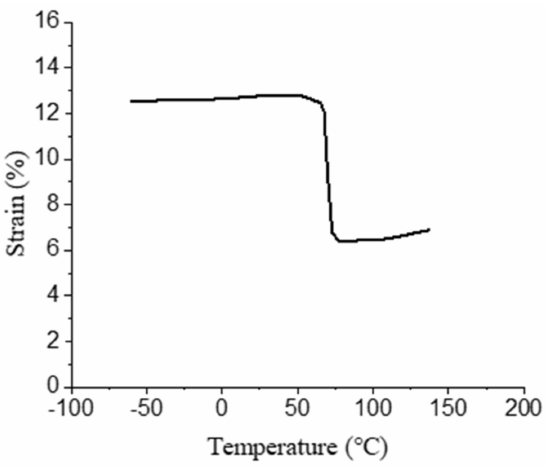
Figure 6. The stress-temperature curve of NiTiNb SMA heated after